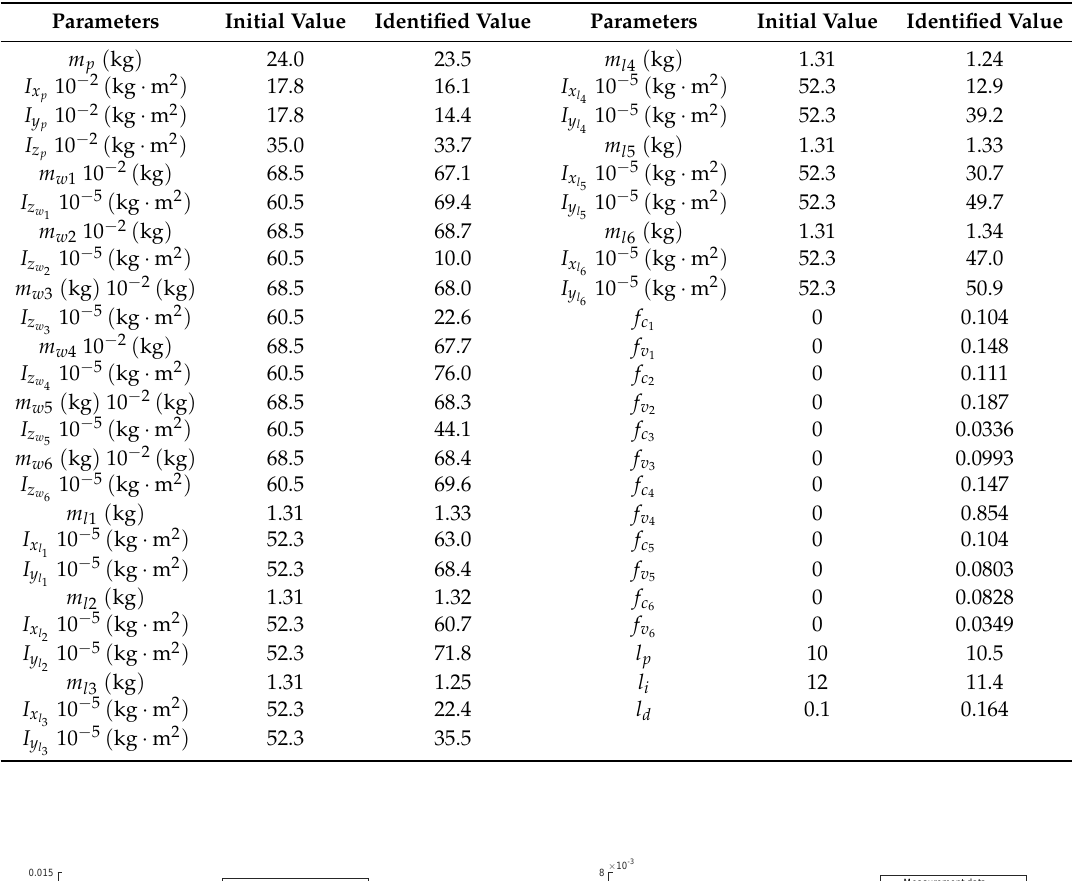
Table 2. Identified parameters of 6-RSS parallel robot.